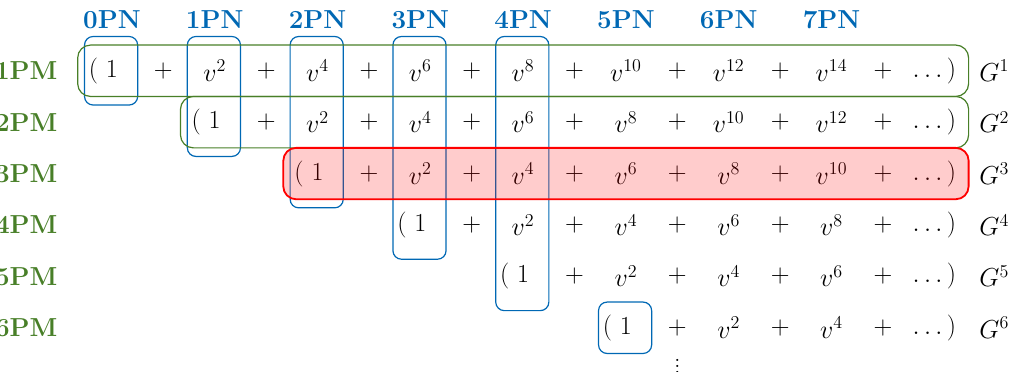
Figure 1 . A summary of known results for the two-body potential for spinless black holes in the PN and PM expansions, outlined in blue and green regions respectively. The new 3PM result summarized in ref. [59] and discussed at length in this paper is highlighted in the shaded (red) region. The overlap gives strong crosschecks on any calculations in either